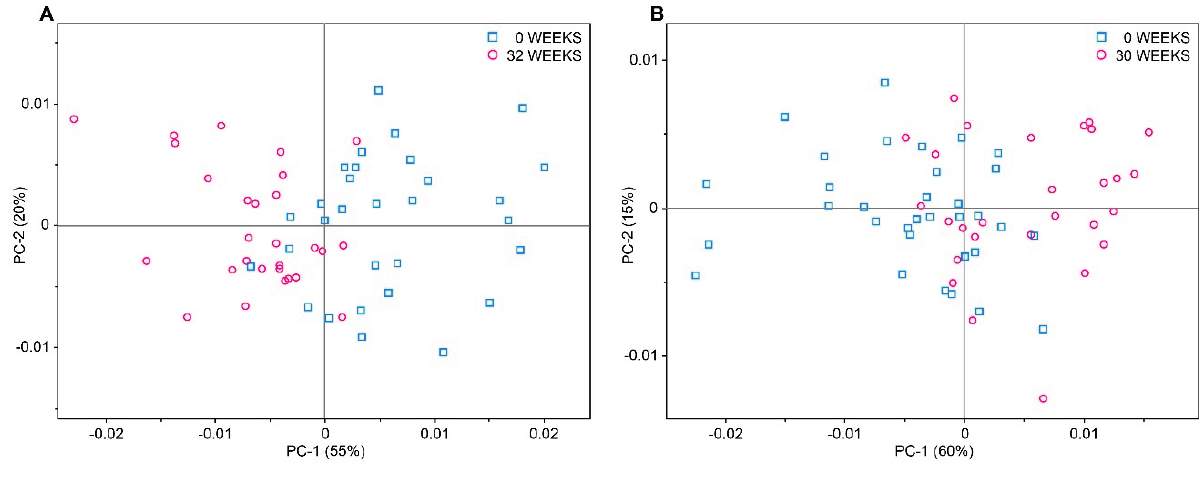
Figure 2. PCA score plot of NIR data acquired from freshly harvested (0 weeks) and long-term stored (32/30 weeks) apples from the optimal harvest date (HT1). ( A ) “Braeburn” ( B ) “Cripps